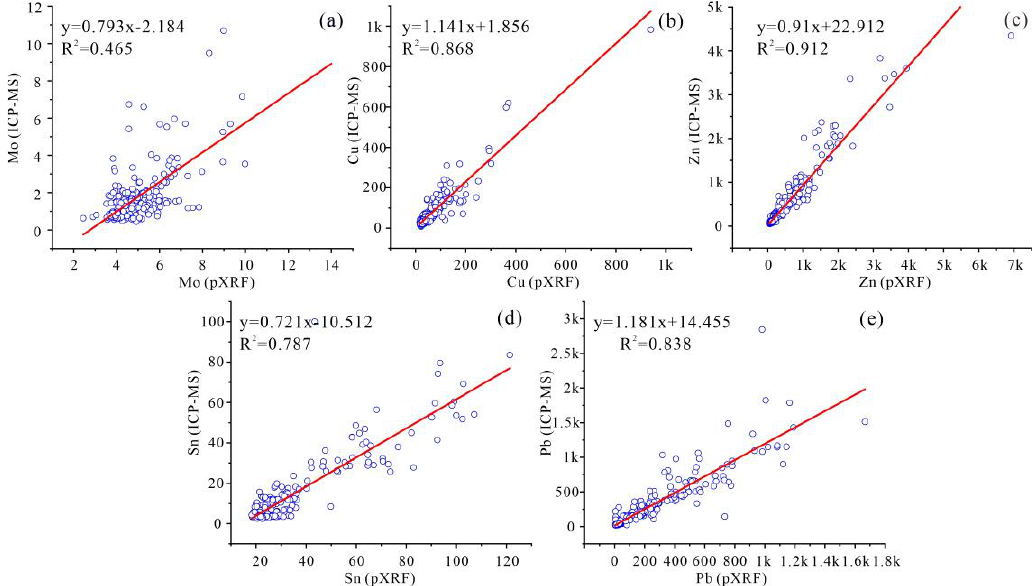
Figure 4. Regression analysis of pXRF and ICP- MS, in μg/g; ( a ) Mo; ( b ) Cu; ( c ) Zn; ( d ) Sn; ( e ) Pb. Figure 5. Regression analysis of pXRF and ICP-MS, in µ g/g. ( a ) Mo; ( b ) Cu; ( c ) Zn; ( d ) Sn; ( e )